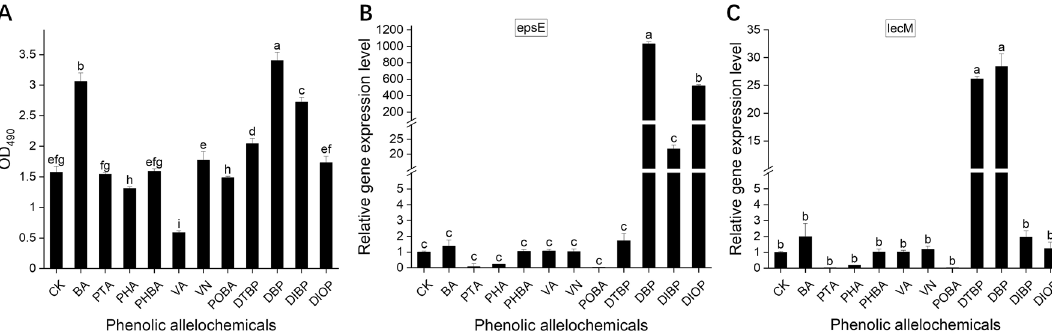
Figure 2. Effects of PAs on biofilm formation of Ralstonia solanacearum 1–1. ( A ), quantitative detection of biofilm of Ralstonia solanacearum 1–1 treated with PAs by crystal violet staining method; The colony numbers of R. solanacearum 1-1 under different PAs treatments were determined; ( C ), the relative expression level of epsE and lecM gene of Ralstonia solanacearum 1–1 in NB medium supplemented with PAs.